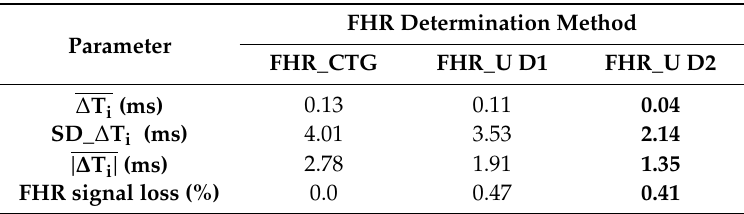
Table 5. Final results obtained for various methods for FHR_U signal determination based on a raw US signal in relation to the reference FHR_E from direct FECG.